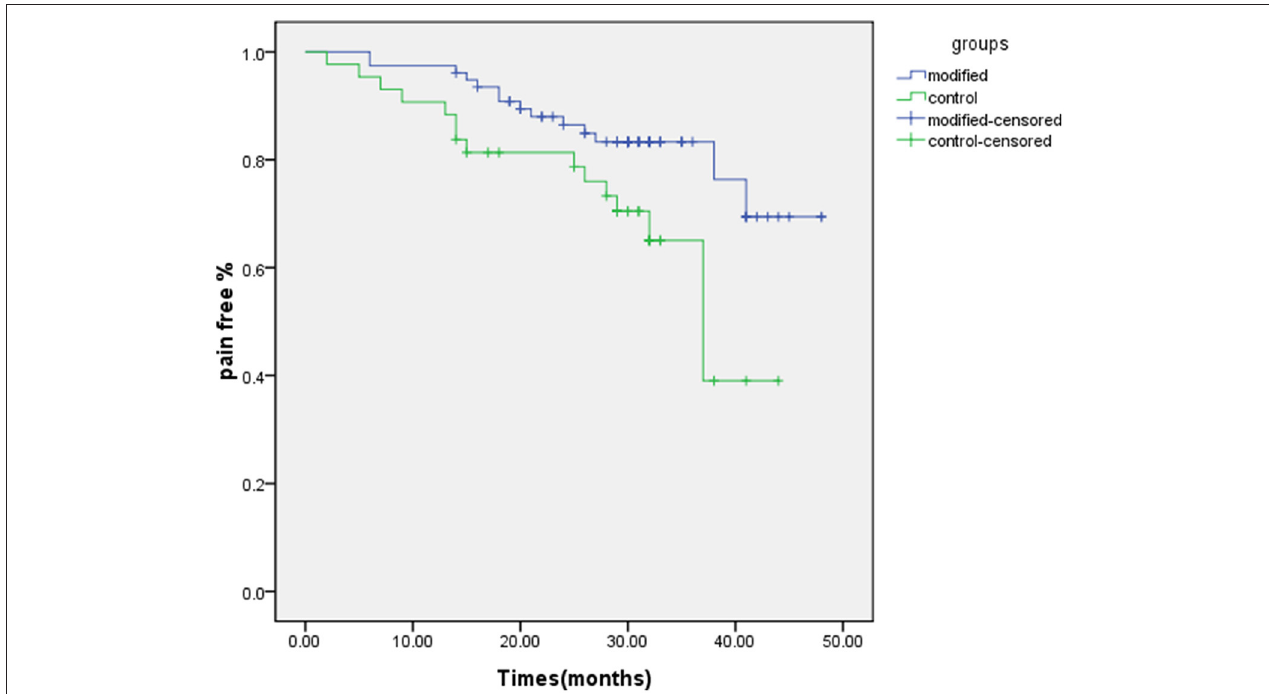
FIGURE 3 | Kaplan-Meier survival curve showed that the postoperative pain-free maintenance period was significantly higher in the modified group than in the classic group ( P = 0.025). The mean follow-up was 30.2 months.